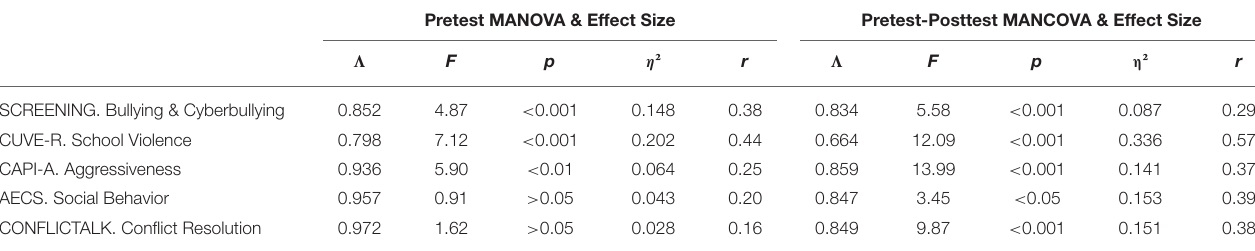
TABLE 4 | Results of the Pretest MANOVAs, of Pretest-Posttest MANCOVAs, and Effect Size ( η ² ) in all grouped variables, between experimental and control groups. Pretest MANOVA & Effect